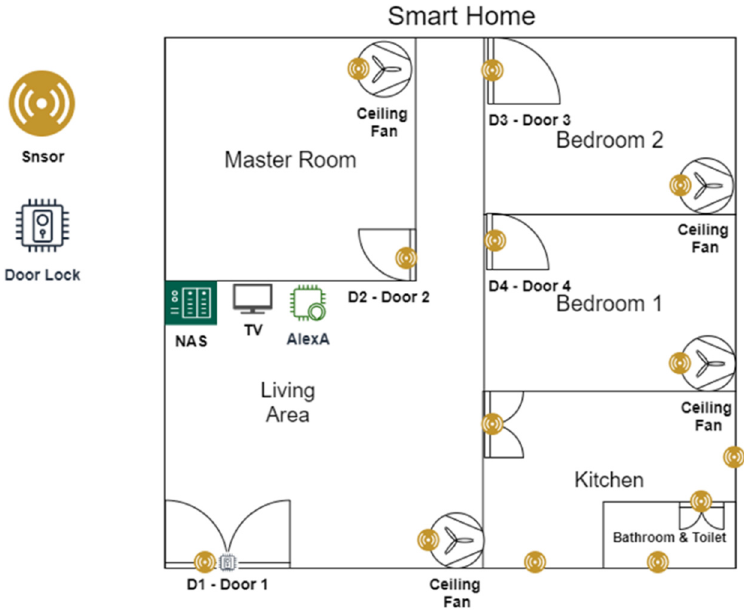
Figure 4. Physical layout of a smart home prototype with IoT deployment.